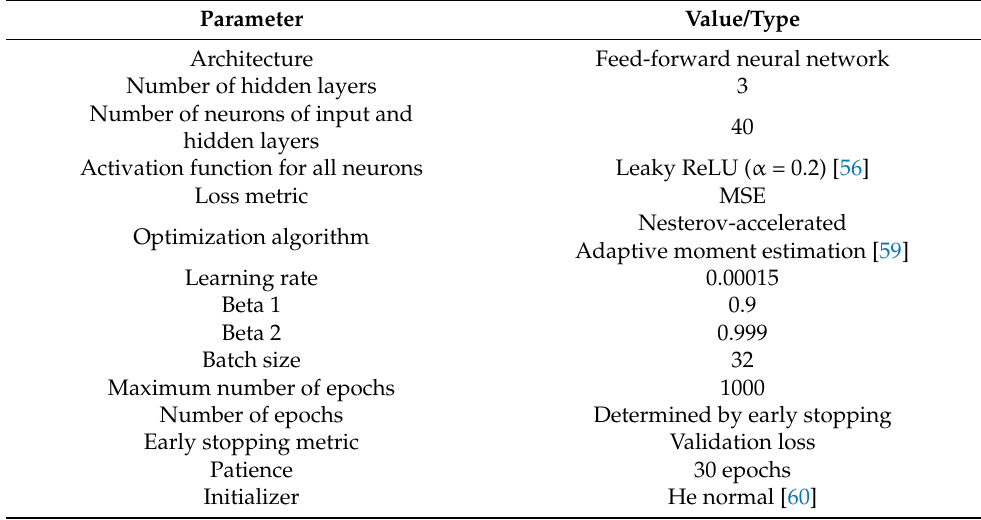
Table 1. Parameters of the ANNs used in this study. The final parameters and values were derived through multiple rounds of iterative testing (see Appendix